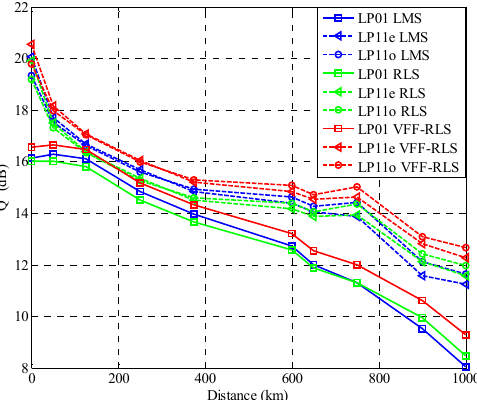
Figure 16. Comparison between conventional least mean square (LMS) and VFF-RLS / RLS: Q 2 vs. Distance.